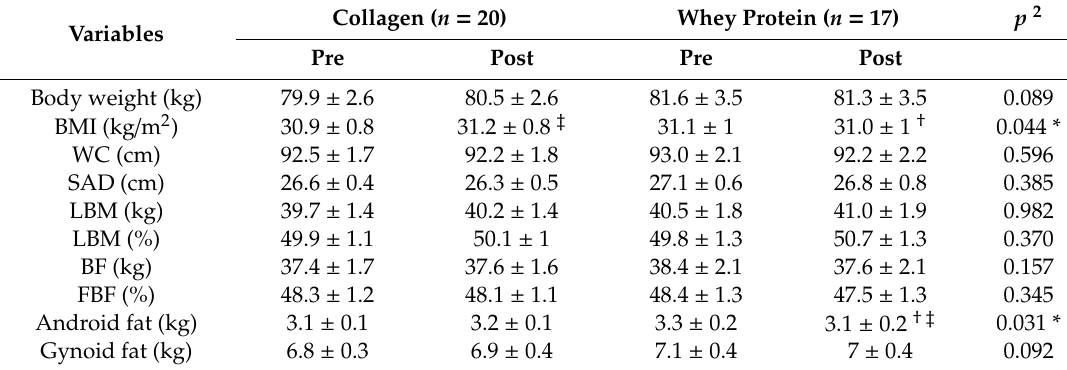
Table 3. Body composition 1